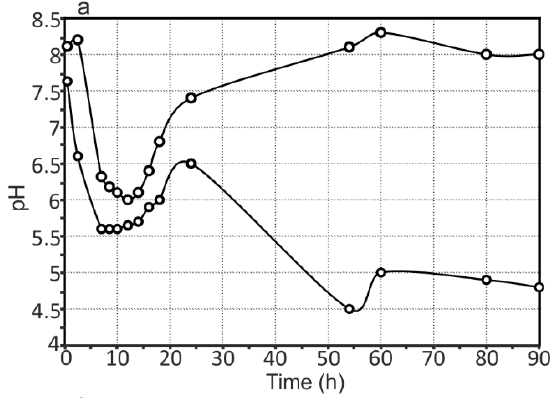
Figure 12. ( a ) pH max and ( b ) pH min as a function of time and ∆pH evolution with time for the 1579 Al alloy sample. This specimen varies very intensively, from 0.35 to 3.60, confirming the high corrosion activity of the welded 1579 aluminium alloy. 4. Conclusions Analysis of the corrosion behaviour of the bare 1579 Al alloy with a welded joint area revealed the following conclusions: